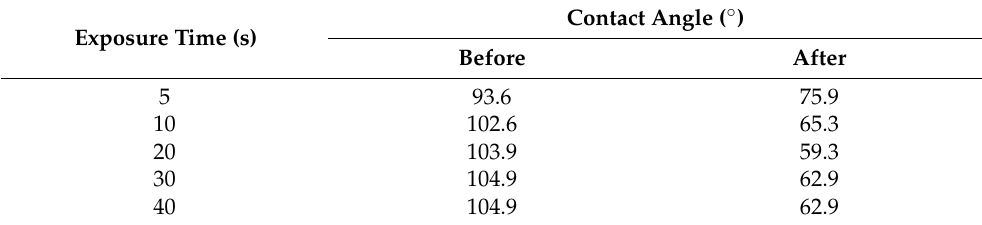
Table 3. Water contact angle as a function of exposure time at 0.28 mA/cm 2 current density. Exposure Time